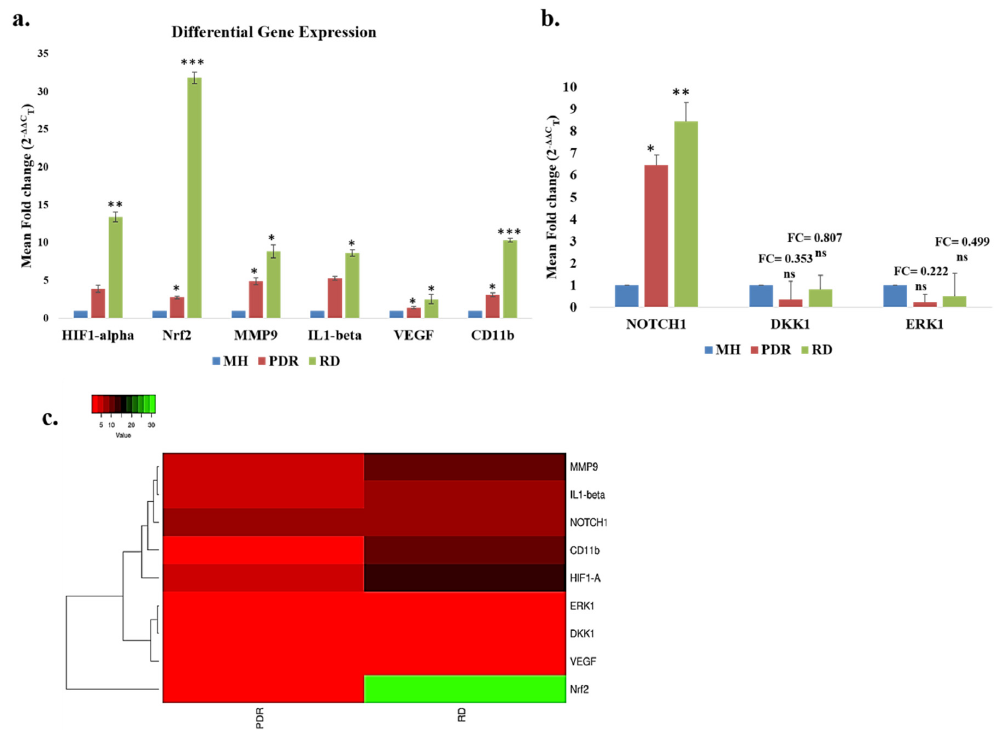
Figure 5. ( a and b ) Differential gene expression analysis of oxidative stress, inflammatory markers and their associated pathway involved in the pathogenesis of epiretinal membrane of RD, PDR compared to macular hole (* p ≤ 0.05, ** p ≤ 0.01, *** p ≤ 0.001) ( c ) Heat map showing the expression pattern of the differentially expressed genes in PDR and RD.